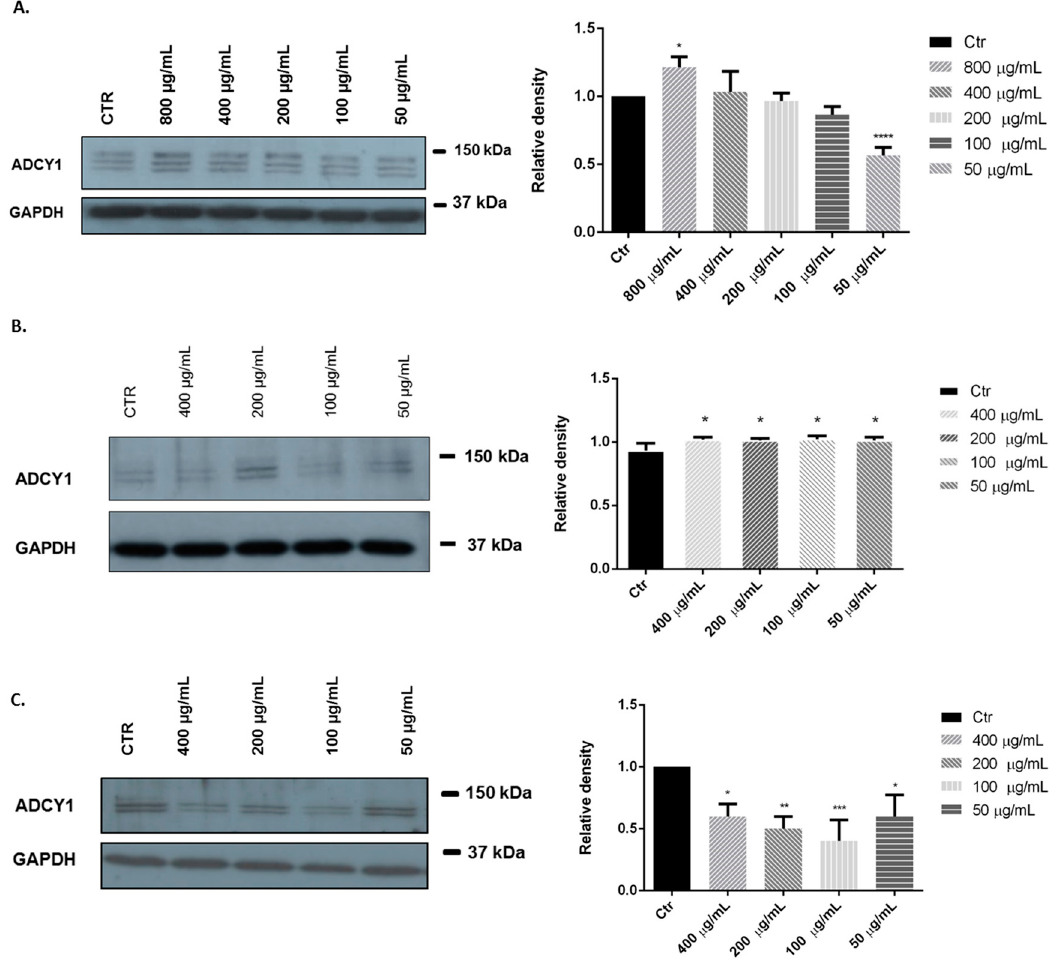
Figure 4. Relative expression levels of the ADCY1 in SH-SY5Y treated with limonene ( A ); C. medica cv. ‘liscia’ ( B ); and C. medica cv. ‘rugosa ( C ) EOs. Each panel shows a representative Western blot and densitometric analysis of bands in the control and treated groups. Values are the mean ± SD in each group ( n = 3). * p < 0.05, ** p < 0.01, *** p < 0.001, **** p < 0.0001, compared to control (ANOVA followed